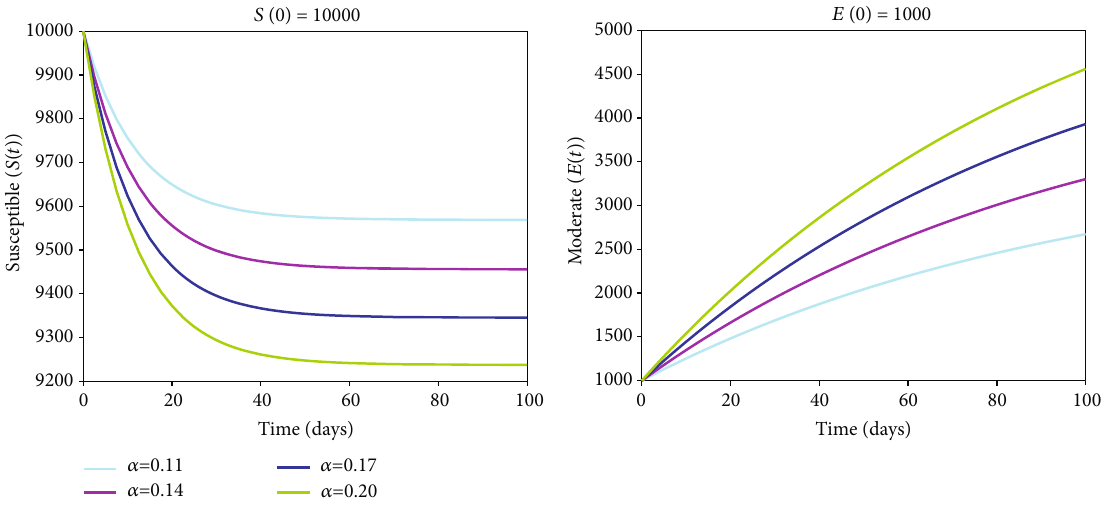
Figure 6: Addicted and quitter population with varying recovery rate ( θ )